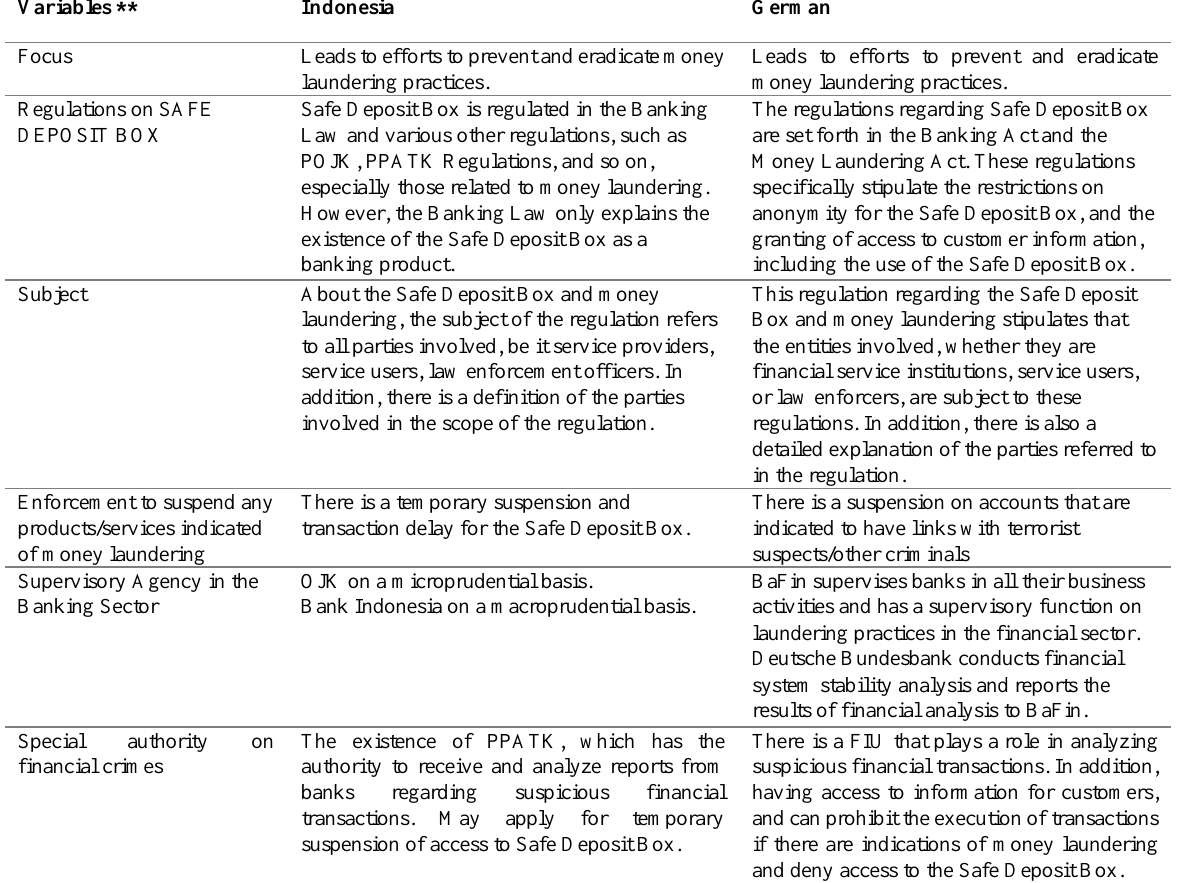
Table 1: Comparison of Landscape of Regulations in Indonesia in Indonesia and Germany Variables